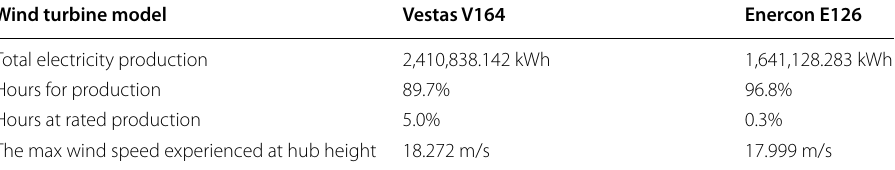
Table 5 Summary of the performance overview of the wind turbines in October 2020, Esbjerg,